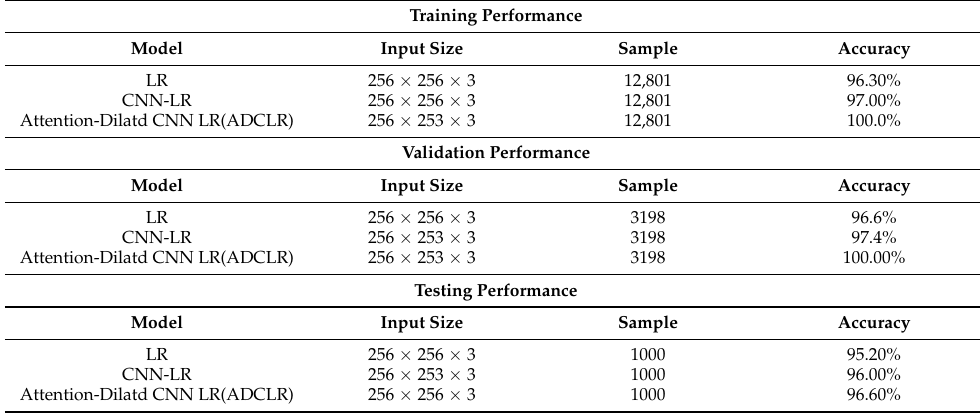
Table 6. The performance comparison of three related models (training, validation and